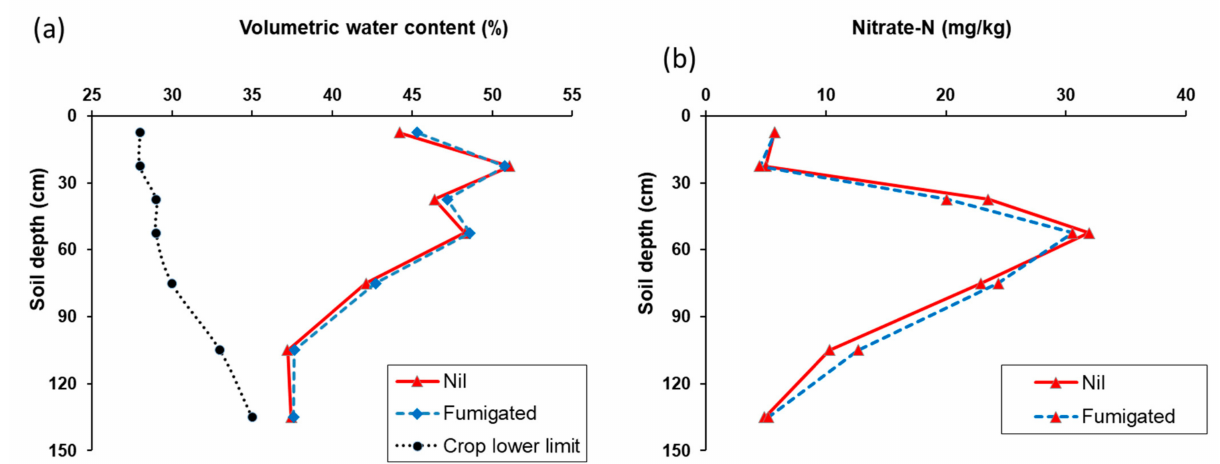
Figure 6. ( a ) Volumetric water content (%), and ( b ) nitrate-nitrogen concentration (mg/kg) in the soil profile from fumigated and nil treatments before sowing Experiment 3. There were highly significant differences due to soil depth for both soil water and nitrate nitrogen, but not due to fumigation or interaction of fumigation and soil depth in